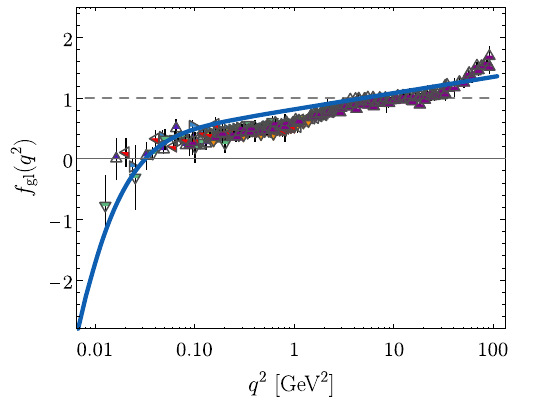
description obtained in [62] when solving the BSE in the absence of ghosts. (Right panel) the ghost-gluon vertex form factor f gh in the sym- metric configuration obtained from solving its SDE